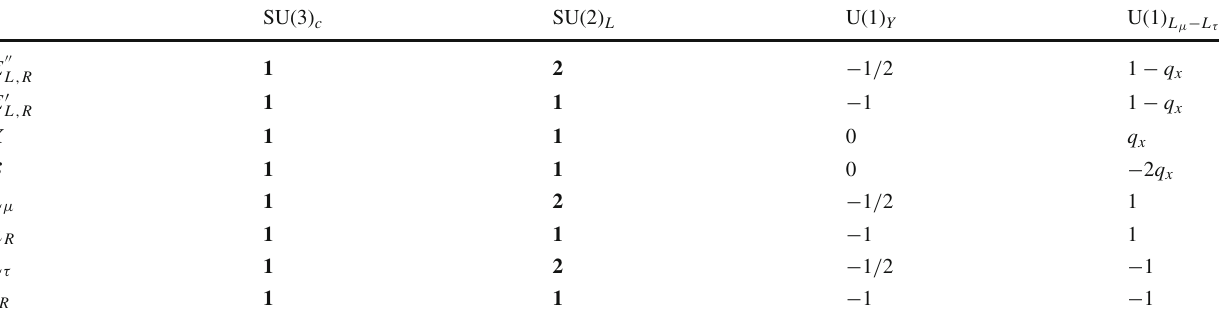
Table 1 The quantum numbers of the fields charged under U ( 1 ) L μ − L τ . The charge of the other field is